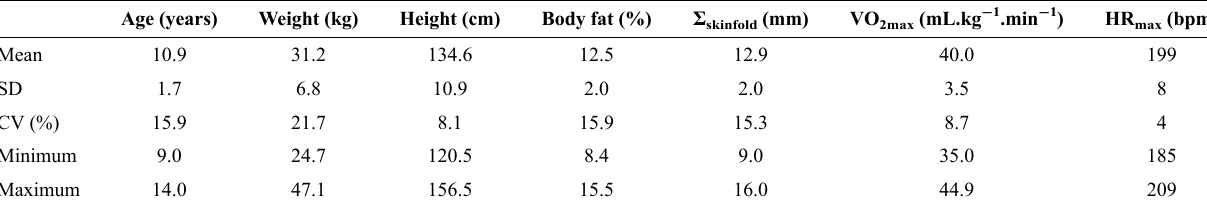
Table 1 - Anthropometric and physiological characteristics of the